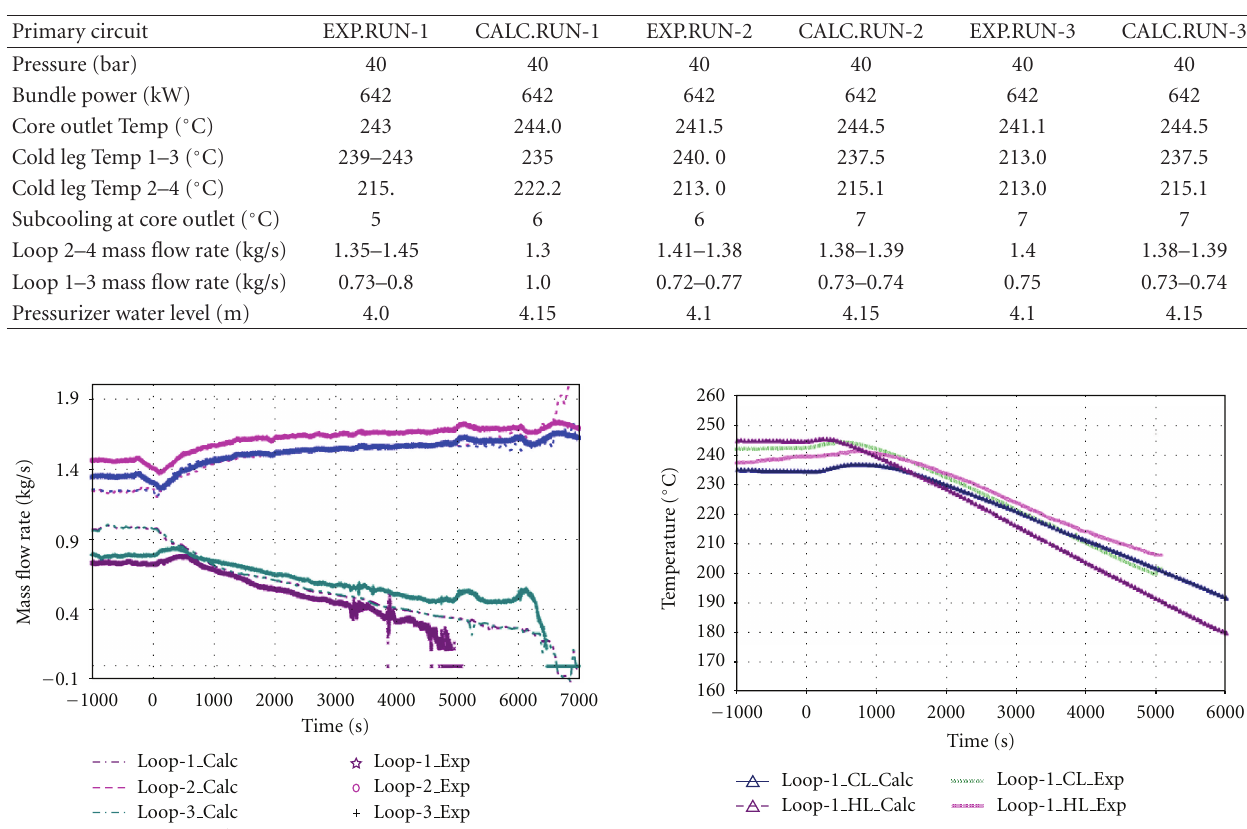
Table 6: Primary side steady-state results versus measurements for all runs.